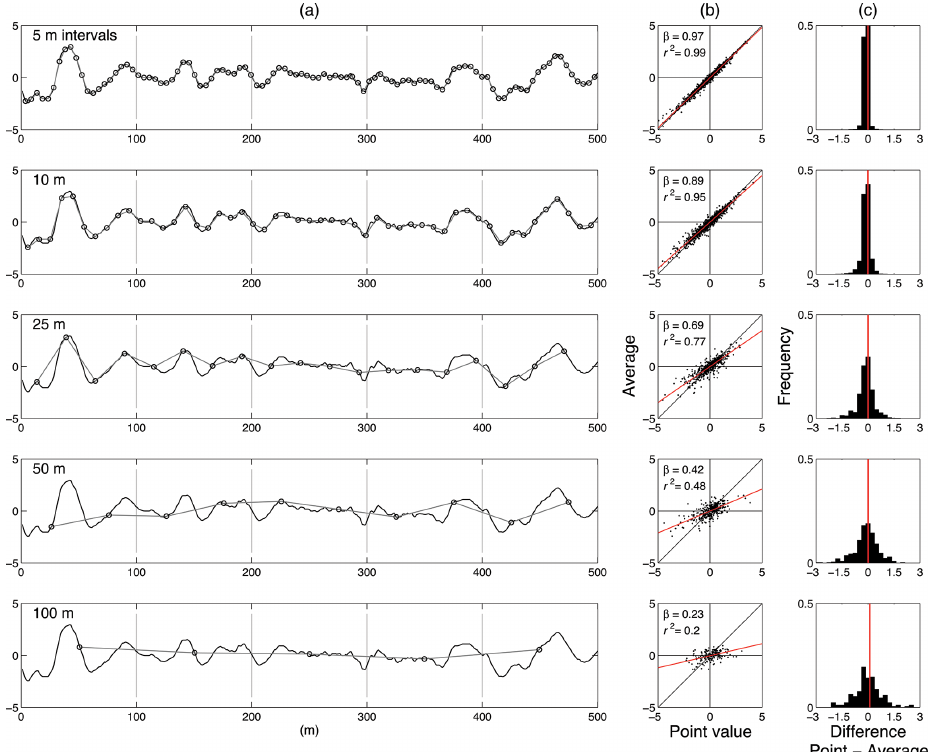
Figure 3. (a) As Fig. 2 but for an open and wind influenced environment at the Rabbit Ears–Walton Creek (RW) ISA of the CLPX (Trujillo et al., 2007; Cline et al., 2009). (b) Average values within sampling intervals (same as in a ) vs. point samples for normalized snow depth profiles in the RW ISA. The red line is a linear regression fit, with slope β and r 2 as indicated in each plot. (c) Histograms of the difference between the point and average values for each of the sampling intervals. The vertical red line marks the mean difference.